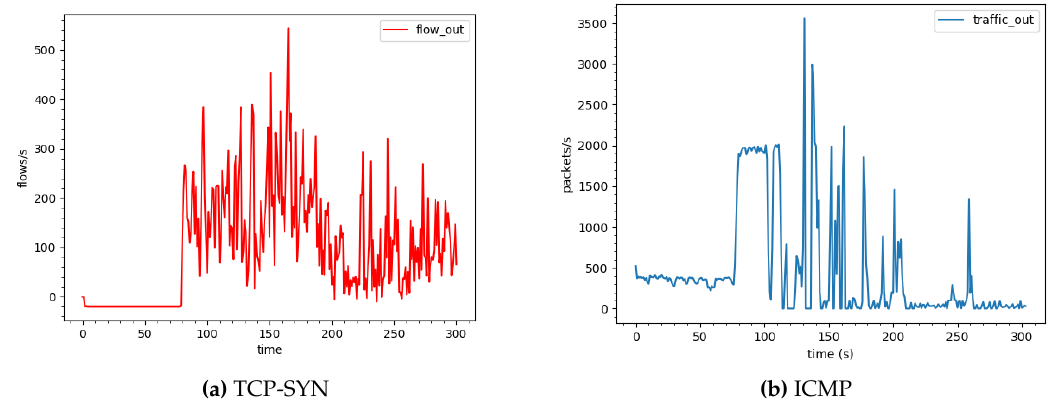
Figure 11. Attack traffic volume arriving at the victim: ( a ) TCP-SYN (flows per second) and ( b ) ICMP (packets per